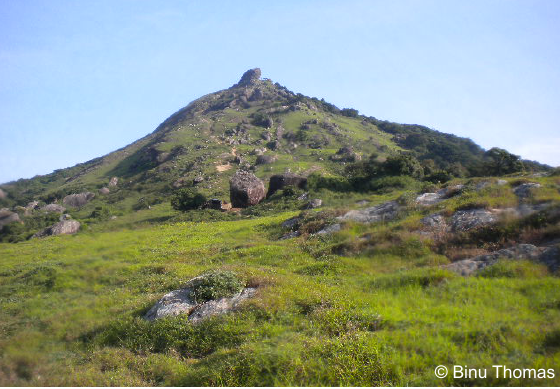
Image 1. View of Velliangiri hill top